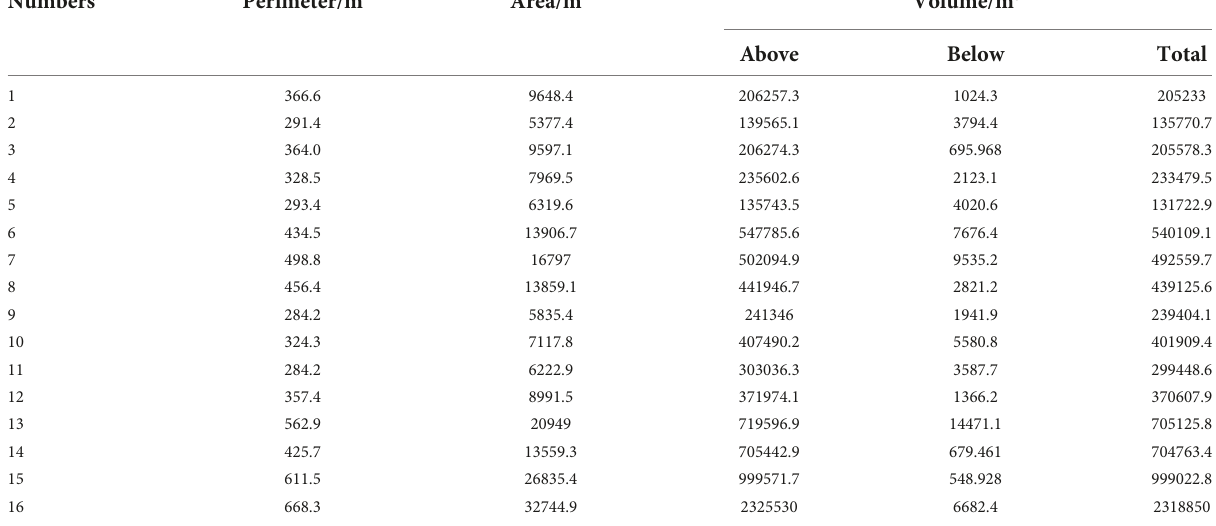
TABLE 3 The bottom perimeter, surface area, and volume of the